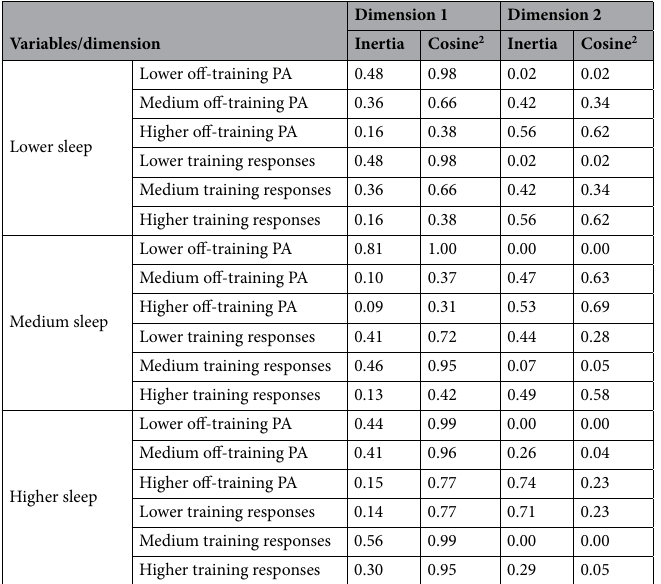
Table 2. Description of the results obtained in the correspondence analysis for sleeping patterns of the three groups. PA physical